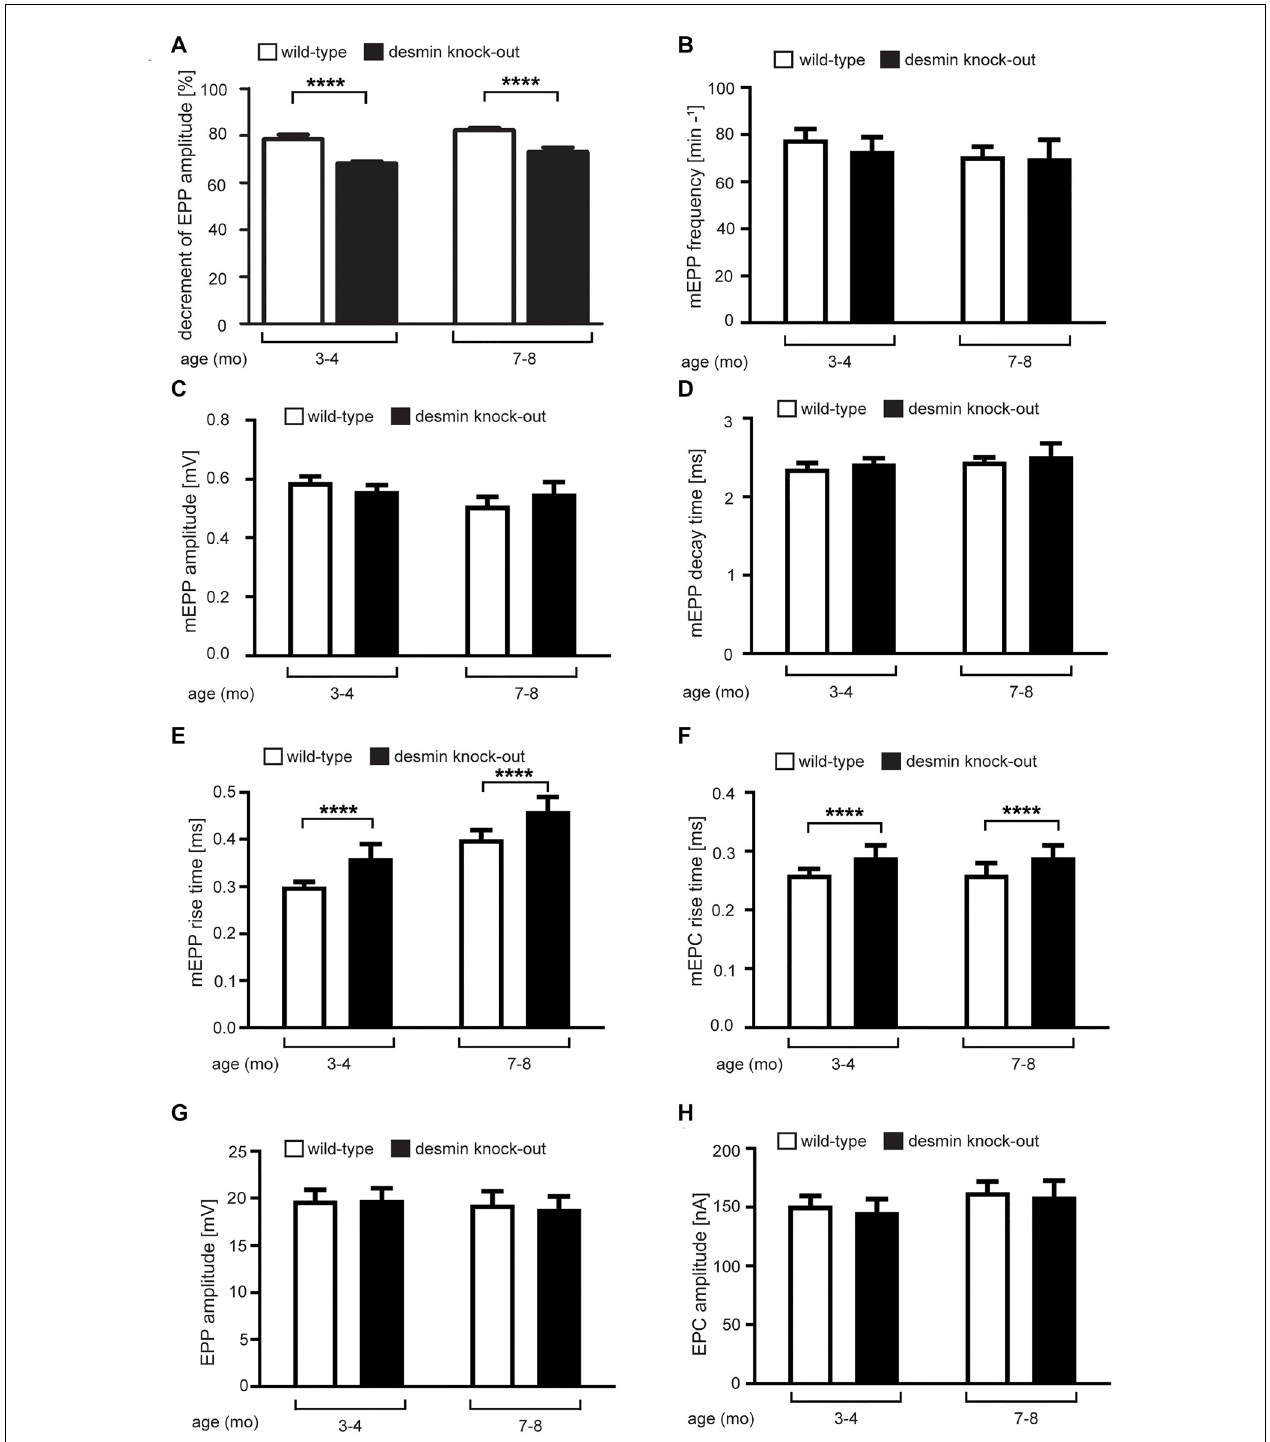
FIGURE 6 | Electrophysiological recordings of desmin knock-out mice muscle fibers reveal a higher decrement after repetitive stimulation and increased rise times of mEPPs. Recordings were done with wild-type and desmin knock-out soleus muscles in 3–4 months-old and 7–8 months-old mice. The graphs show these data as follows: (A) Decrement of the endplate potential amplitude, (B) mEPP frequency, (C) mEPP amplitude, (D) mEPP decay time constant, (E) mEPP rise time, (F) mEPC rise time, (G) EPP amplitude, and (H) EPC amplitude. Statistical significance was in all cases determined by unpaired two-tailed t -test (**** P < 0.0001). Note, in desmin knock-out mice the decrement of EPP amplitude was reduced and mEPP/mEPC rise times increased. All other parameters recorded were not changed between wild-type and desmin knock-out genotypes.